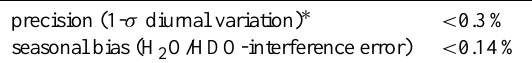
Information on accuracy and precision for methane column-averaged dry-air mole fractions retrieved from mid-infrared solar spectra with the retrieval strategy MIR-GBM